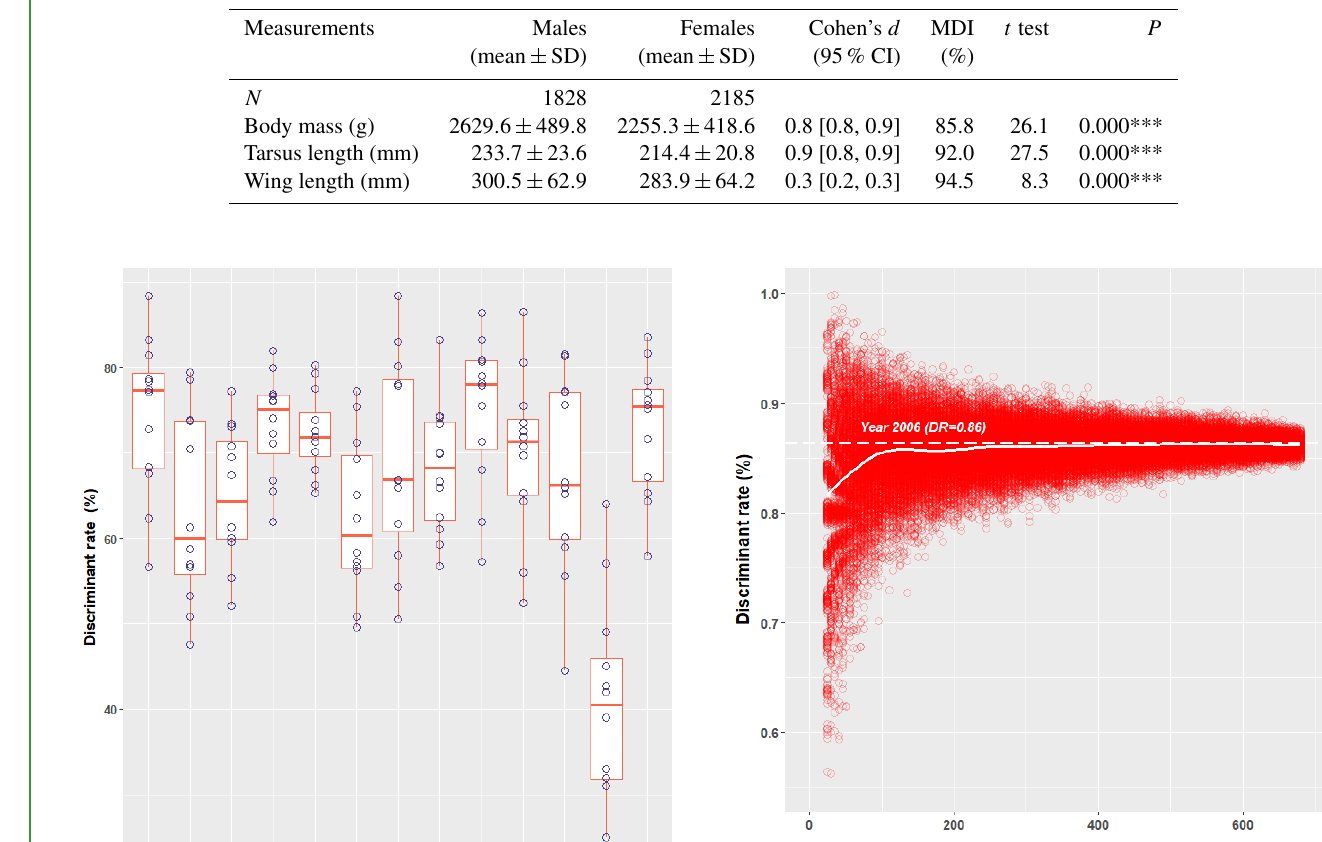
Table 2. Comparisons between male and female greater flamingo chicks on Camargue (1995 to 2008, except 2001, 2002 and 2007) for three characters with mean difference index (MDI) calculated as (mean female / mean male) × 100.